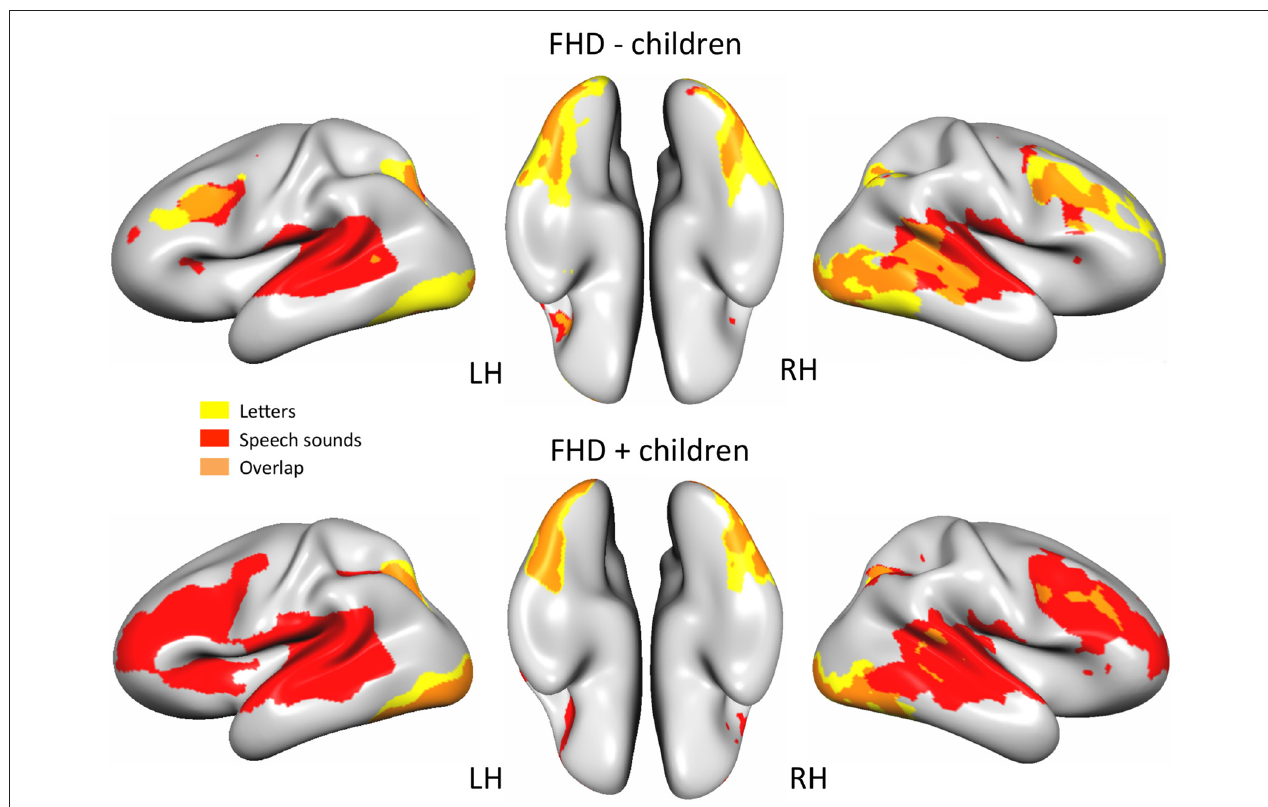
FIGURE 1 | Brain areas involved in processing letters (yellow), speech sounds (red) or both unisensory conditions (orange) in children without (FHD − ) and with (FHD+) family history of dyslexia (DYS; q ( FDR ) < 0.01).